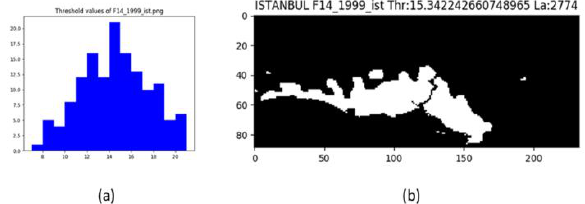
Figure 3. Histogram and binary İstanbul image using cascade mean filter a) Histogram b) Binary İstanbul image